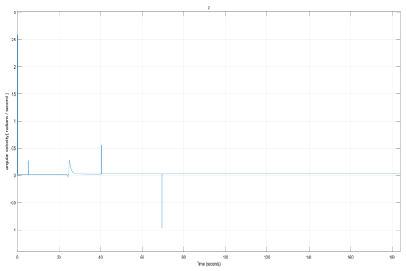
Figure 28. ψ angle around z - axes for the QAV